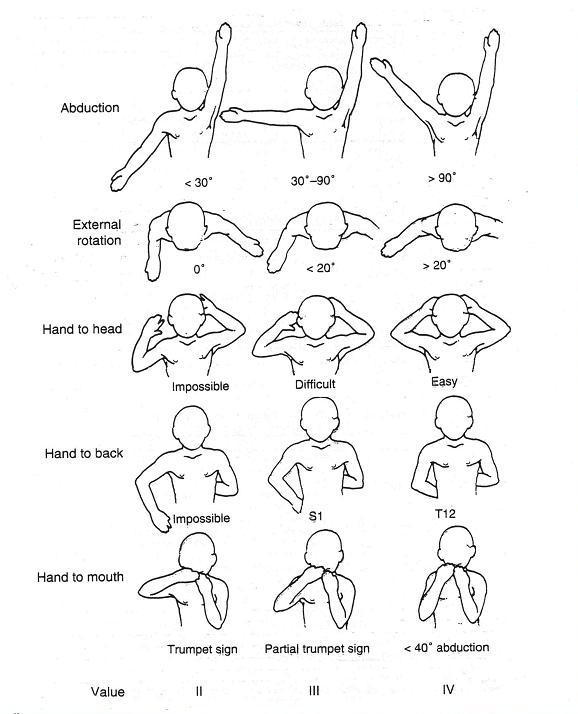
Mallet classification. Grade 0 indicates no movement in the desired plane, Grade V is full movement.